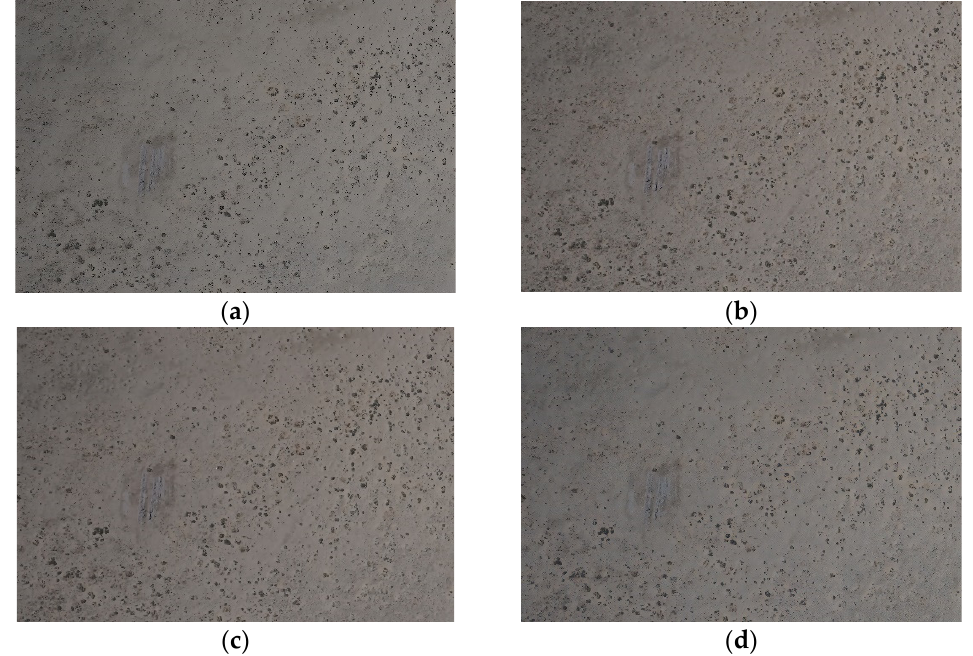
Figure 10. Comparison of results for bare ground in non-green areas ( a ) ESRGAN, ( b ) Real-SR, ( c ) SRMD, ( d ) WAIFU2X. ( c ) SRMD, ( d )